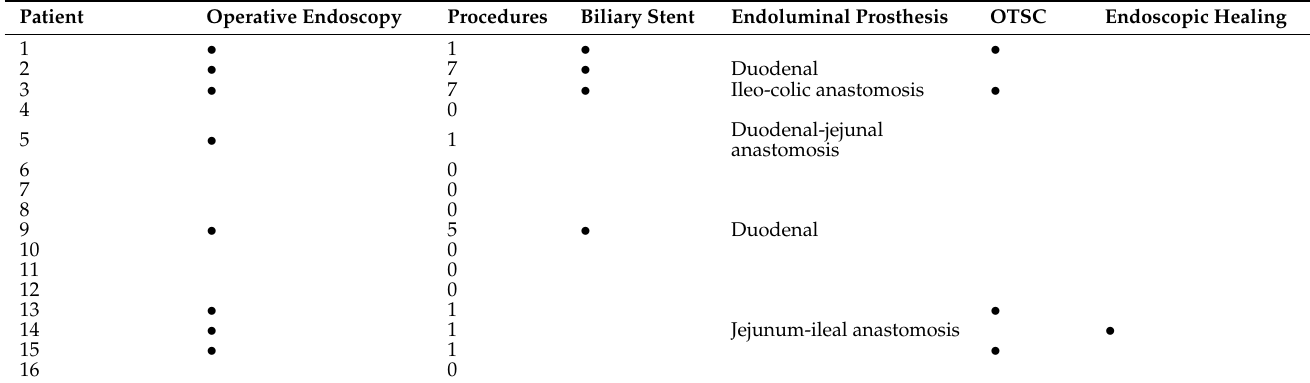
Table 4. Summary of endoscopic management of CEF patients. OTSC, over-the-scope